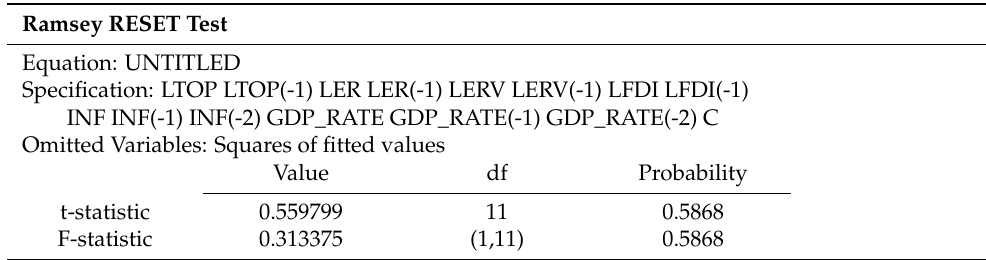
Table A4. Model Specification test